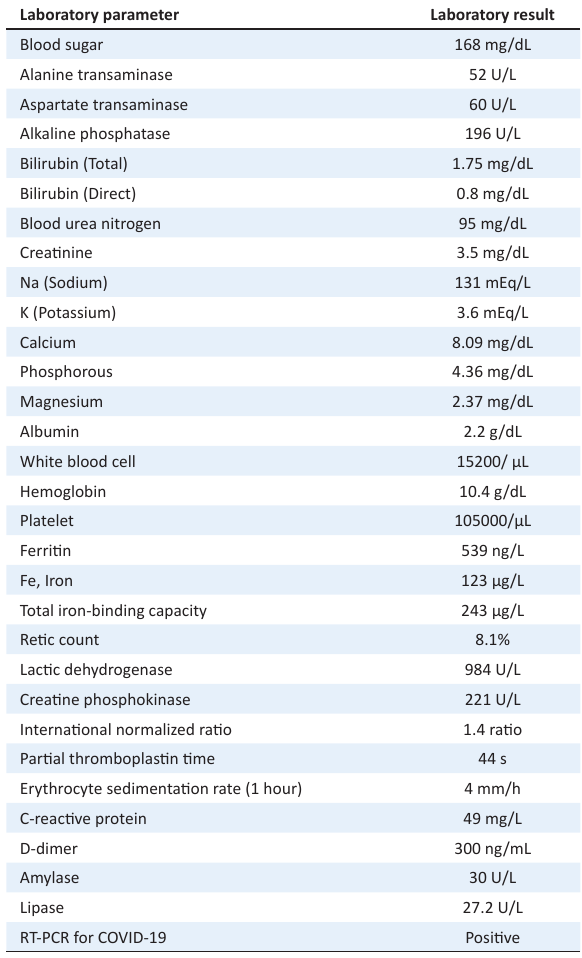
Table 1. The patient’s laboratory